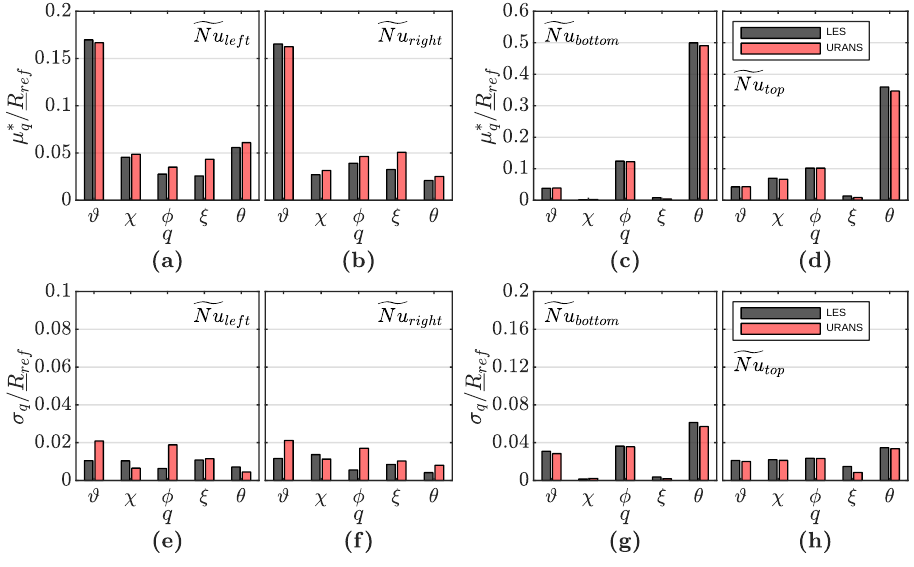
Figure 9. Normalized modified mean µ ∗ / R ref and standard deviation σ q / R ref of the integral mean q Nusselt number: ( a , e ) on the left wall, (cid:102) Nu left ; ( b , f ) on the right wall, (cid:102) Nu right ; ( c , g ) on the bottom wall, (cid:102) Nu bottom ; and ( d , h ) on the top wall, (cid:102) Nu top .